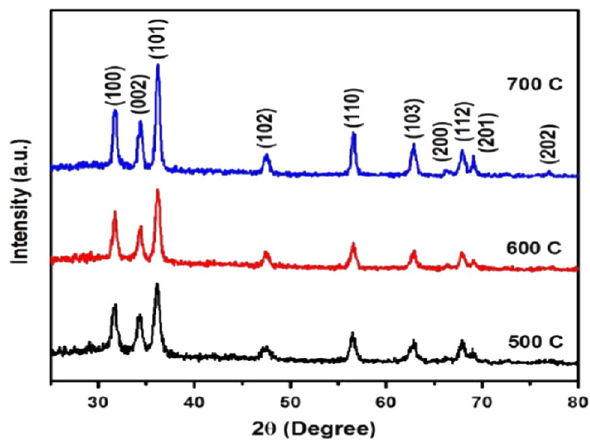
Fig. 11 XRD patterns of ZnO nanoparticles prepared using different calcination temperature: a 500, b 600 and c 700 °C (Golsheikh et al. 2017)